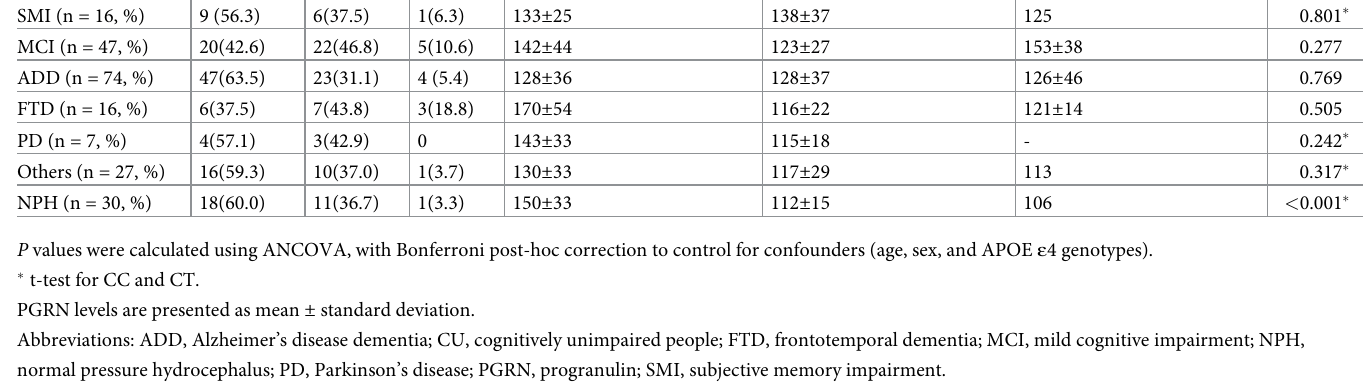
Table 3. Comparison of serum PGRN levels within each diagnostic group and each rs5848 genotype. N within each genotype